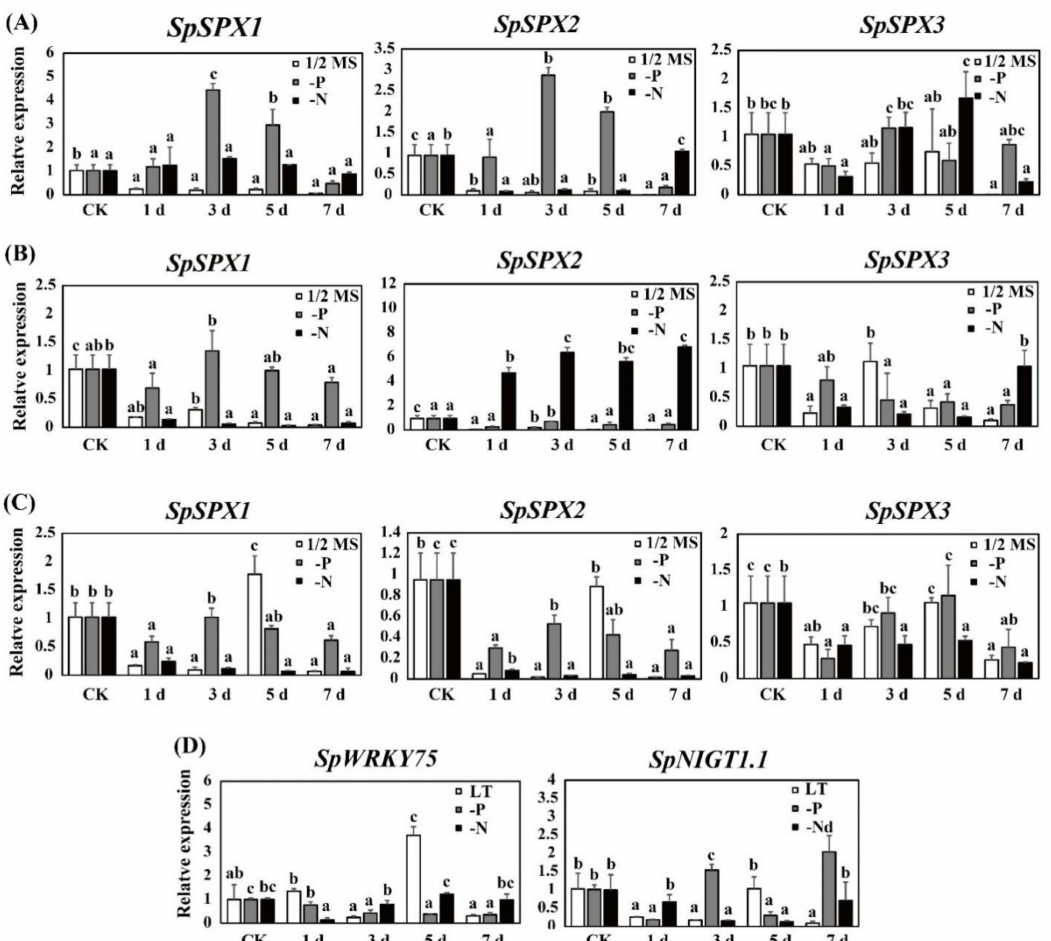
Figure 10. Quantitative RT-PCR analysis of three SpSPX genes under ABA treatment ( A ), osmotic stress ( B ), and LT stress ( C ) in 1/2 MS medium and 1/2 MS medium with P/N deficiency (-P, -N) at 0 [CK], 1, 3, 5, 7 d. Quantitative RT-PCR analysis of SpWRKY75 and SpNIGT1.1 under LT stress (10 ◦ C) and low P/N stresses at 0 [CK], 1, 3, 5, 7 d ( D ). Different letters indicate significant difference between treatments at the p < 0.05 level (Duncan test). Error bars indicate standard